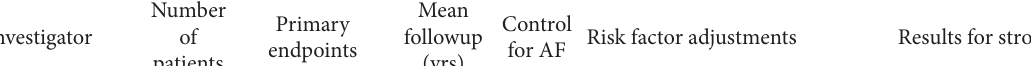
Table 5: OSA and stroke